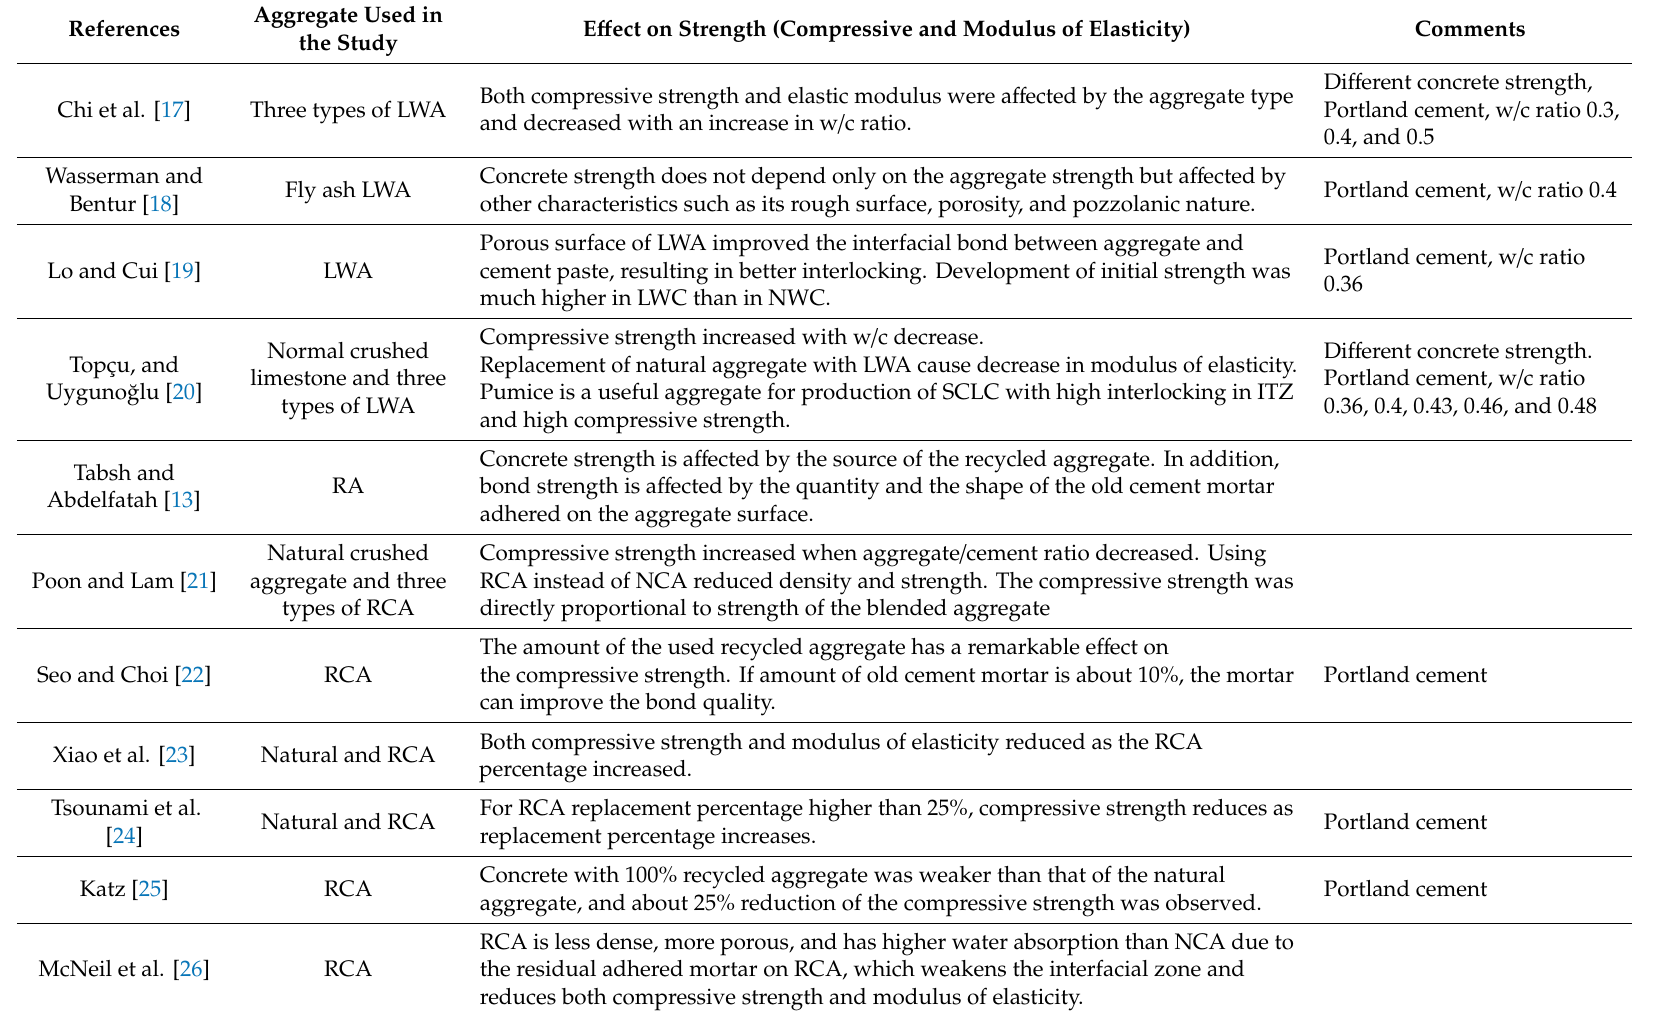
Table 2. The e ff ect of aggregate type on concrete compressive strength